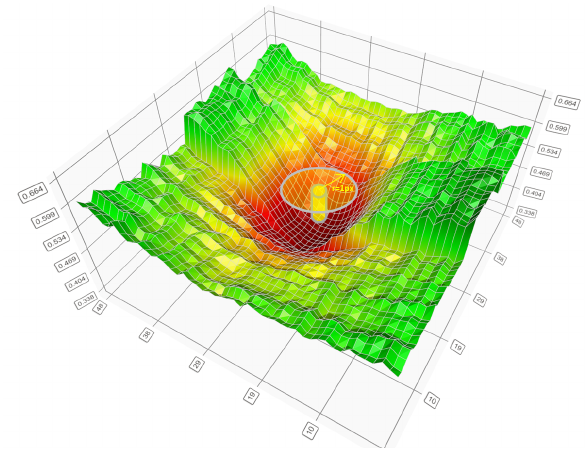
Figure 3. Plot of σ PSF in relation to Siemens star center